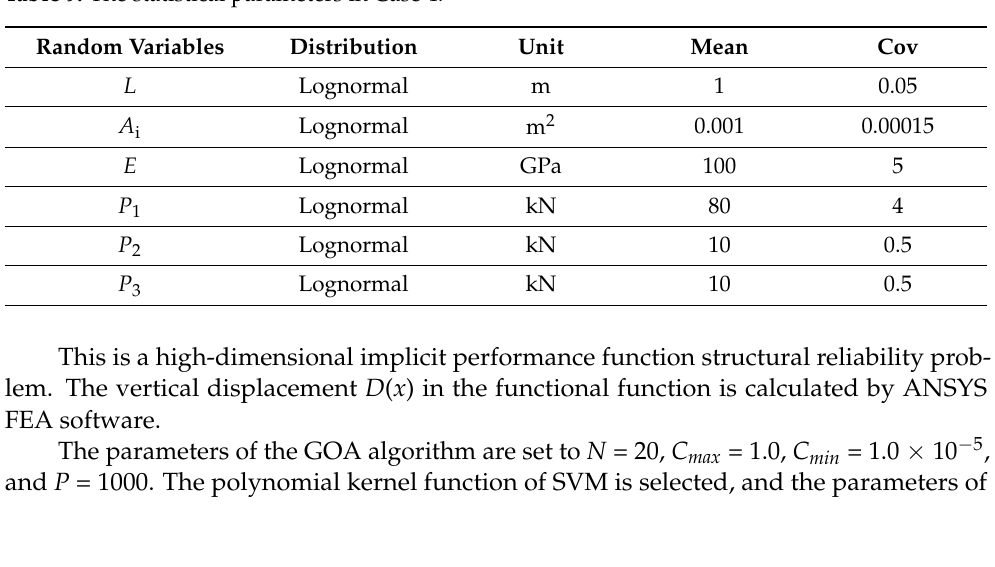
Figure 6. Ten-bar truss. Table 9. The statistical parameters in Case